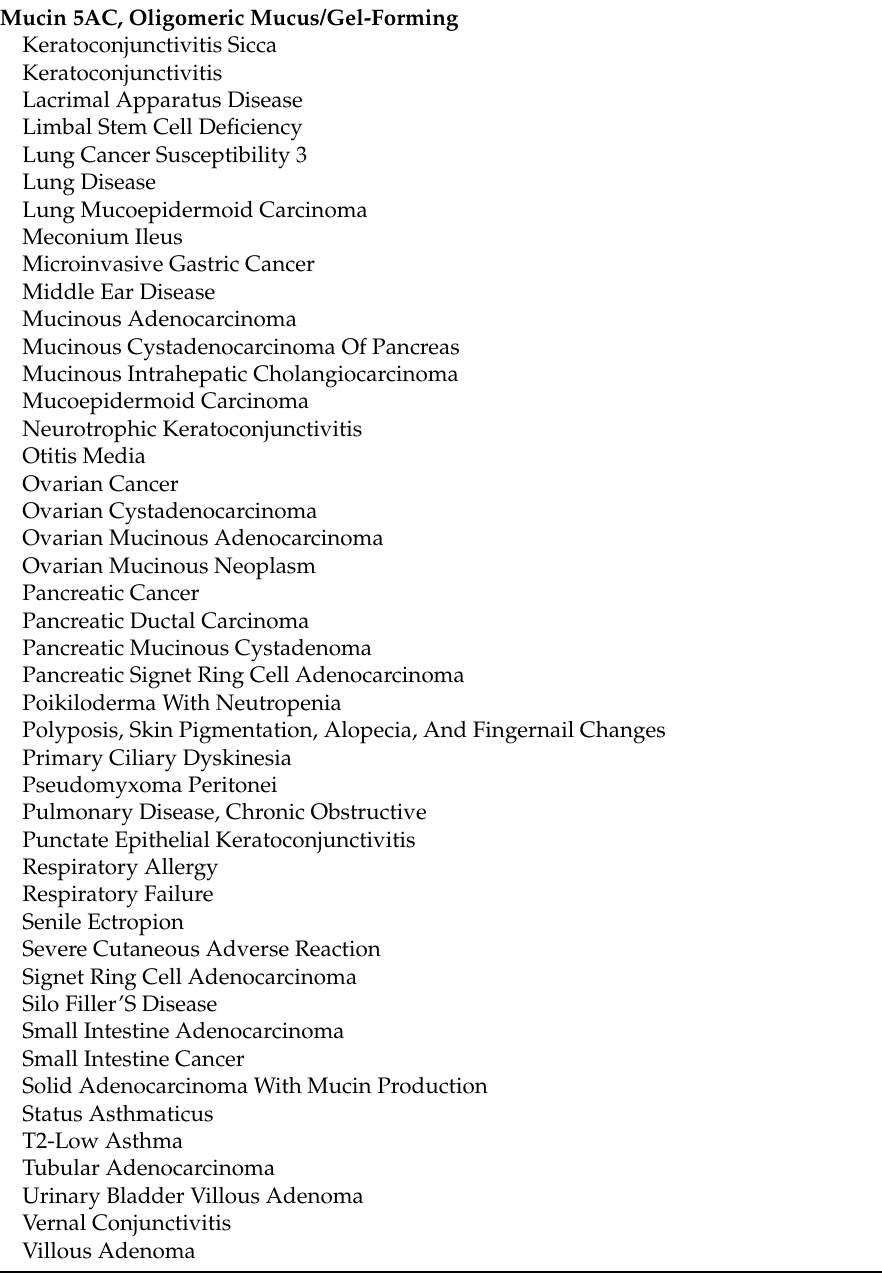
Table A1. Cont. Mucin 5AC, Oligomeric Mucus/Gel-Forming